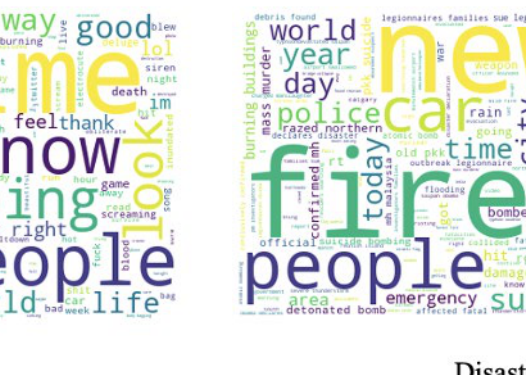
Figure 2. Overview of the top words for disaster and non-disaster tweets.